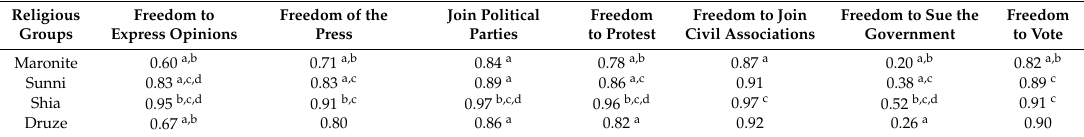
Table 8. Religious Group Mean Perceptions of